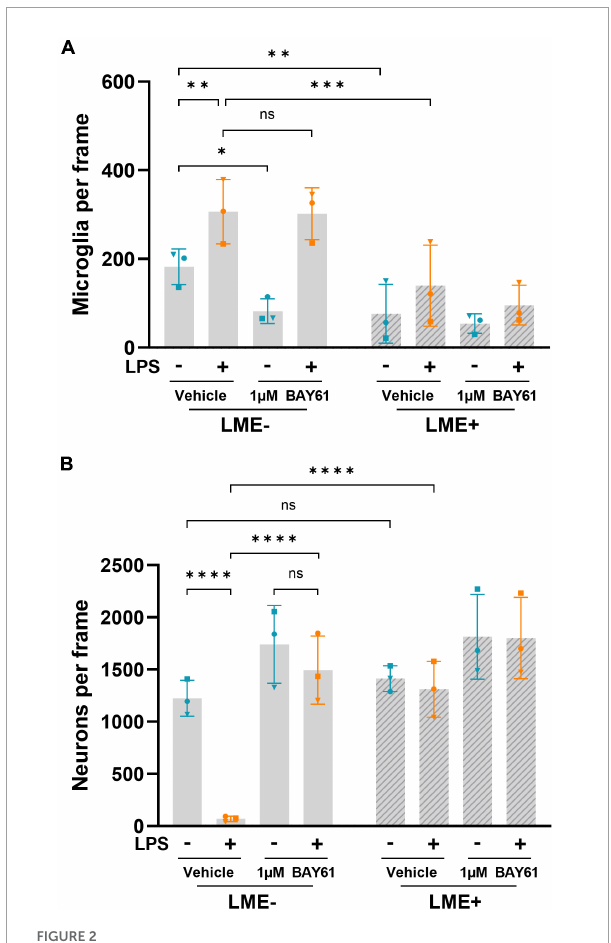
FIGURE2 LPS-induced neuronal loss is dependent on microglia. (A) Average microglial counts per image in neuron-glia cultures treated ± BAY61 (1 µ M) and ± LPS (100 ng/ml) for 3 days (DIV10), after previous ± LME treatment to deplete microglia. (B) Average DIV10 neuronal counts per image in neuron-glia cultures treated ± BAY61 (1 µ M) and ± LPS (100 ng/ml) for 3 days (DIV10), after previous ± LME treatment to deplete microglia. All panels: each datapoint represents the mean of 3 technical replicates. Number of biological repeats = number of datapoints per column. ∗ p < 0.05, ∗∗ p < 0.01, ∗∗∗ p < 0.001, ∗∗∗∗ p < 0.0001. RM 2-way ANOVA with Šídák’s post-hoc